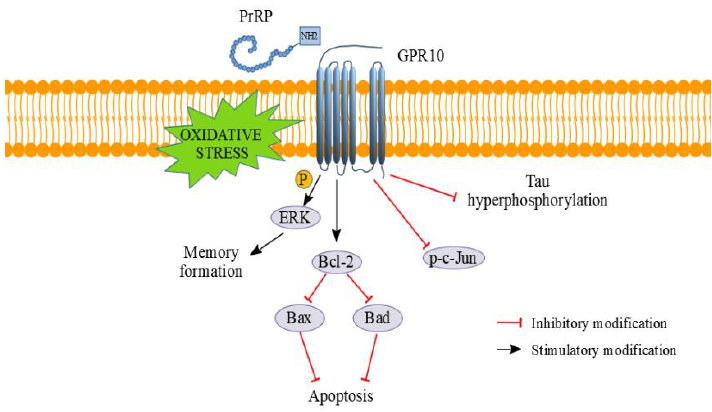
Figure 10. Schematic view of signaling pathways involved in PrRP neuroprotective and anti-apoptotic effect; P–phosphorylation.